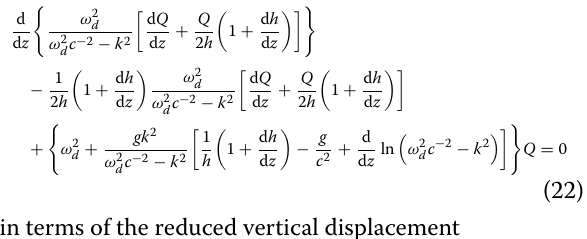
for a set of wave frequencies ω and horizontal wave vec- tors k . The initial conditions (26) ensure that the radia- tion condition is satisfied. In terms of the numerical solution Q 1 ( z ), the vertical displacement in the wave gen- erated by the lower boundary vibrations with the vertical displacement amplitude w 0 is given by